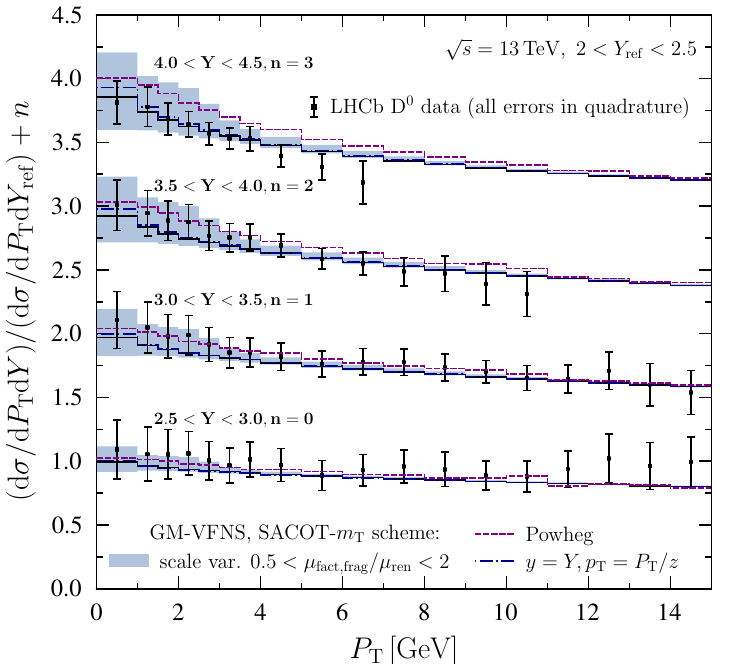
p Figure 15 . Cross sections at s = 13 TeV normalized to the rapidity bin 2 : 0 < Y ref < 2 : 5. Black lines are the central GM-VFNS results, and the light blue band corresponds to the scale variation. The dark blue dashed-dotted lines are the predictions with zero-mass fragmentation variable, and purple dashed ones indicate the Powheg + Pythia prediction. The data are from ref.